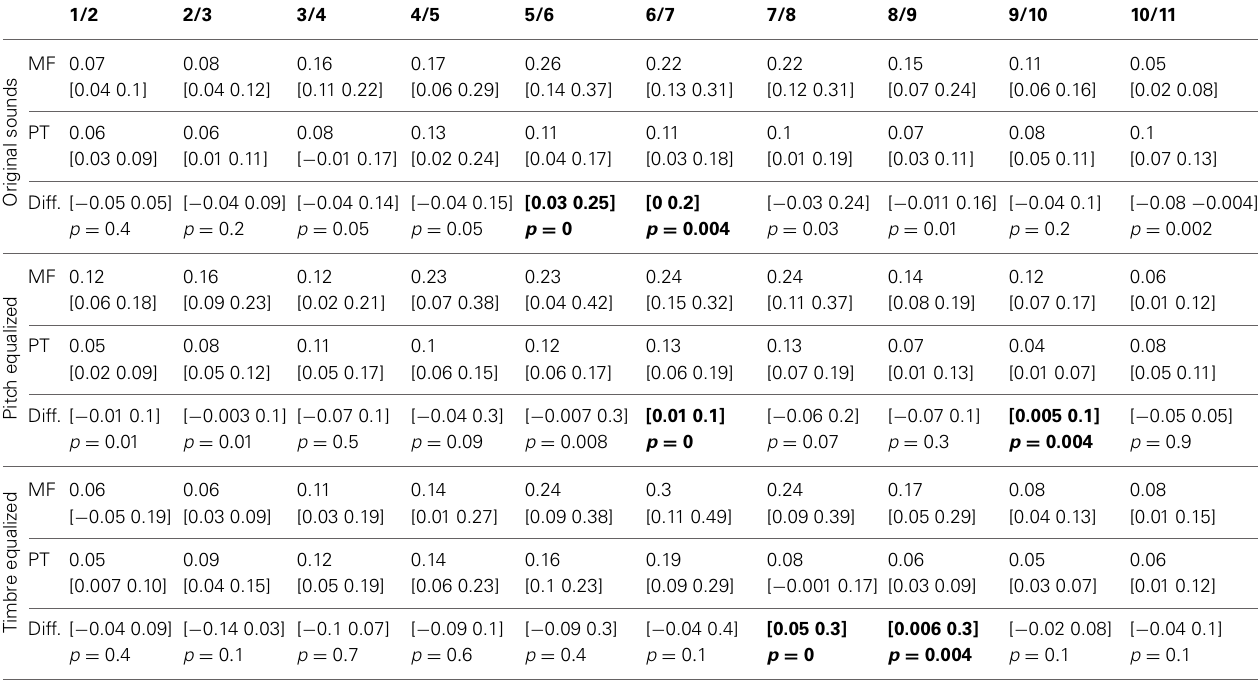
Table 5 | Trimmed mean of the rate of change in RTs (1st derivative) and 95% CI for each task and condition, with 95% confidence intervals and p -values of differences between